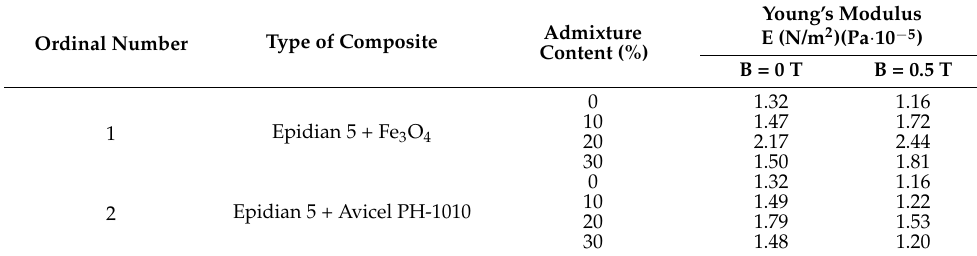
Table 13. Determination of Young’s modulus for selected